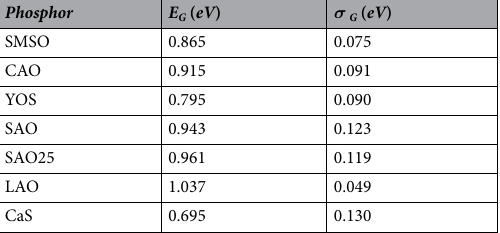
Table 1. Extracted fit parameters to describe the TL data. The value for the frequency factor s and linear heating rate were kept constant for all seven phosphors at 10 12 s − 1 and 0.5 K s − 1